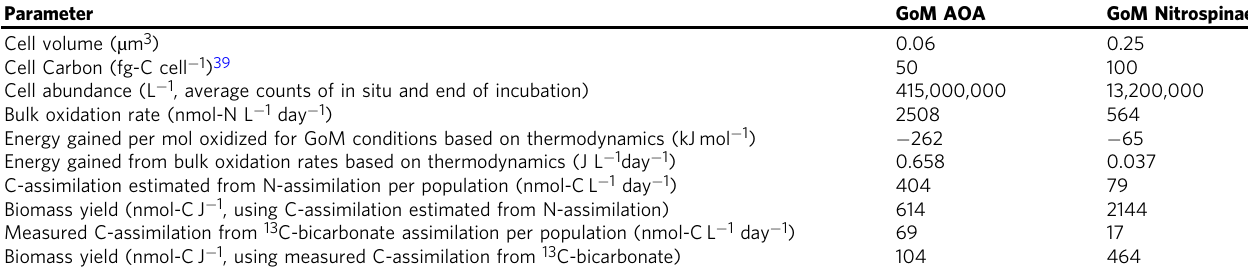
Table 1 Parameters for estimating biomass yield by GoM AOA and Nitrospinae.